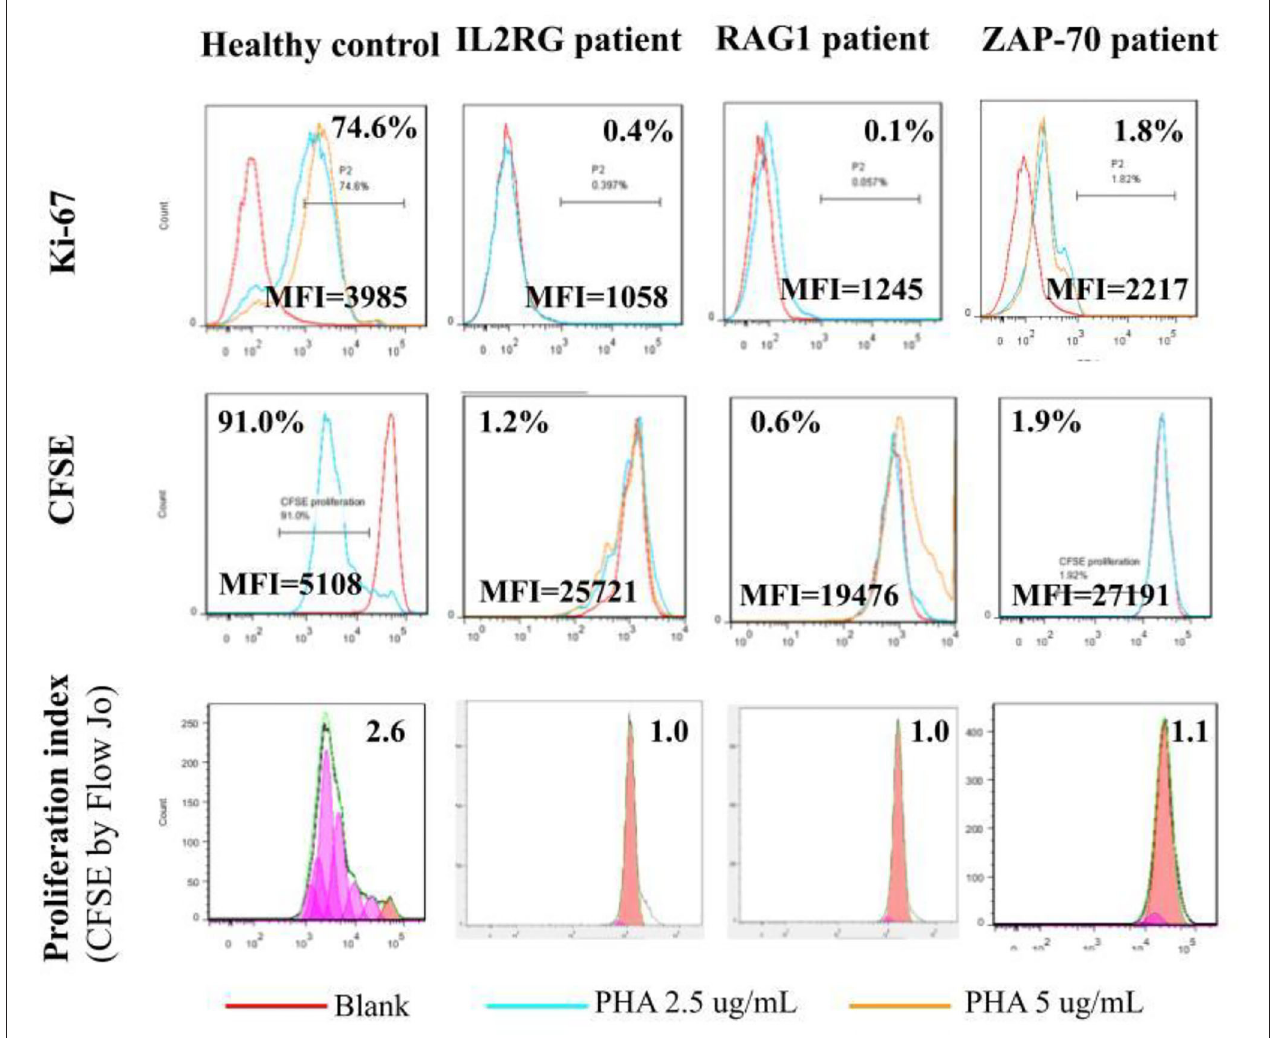
FIGURE 3 | The lymphocyte proliferation assessed by [ 3 H]-thymidine incorporation in the patients with the IL2RG , RAG1 , and ZAP70 mutation ( Figure 2 ) was < 10% of the healthy normal proliferation and consistent with intracellular Ki-67- (0.4, 0.1, and 1.8% vs. 74.6%) and CFSE-stained (1.2, 0.6, and 1.9% vs. 91.0%) lymphocytes. The CFSE proliferation index was approximate 1.0 and far from 2.6 in the healthy